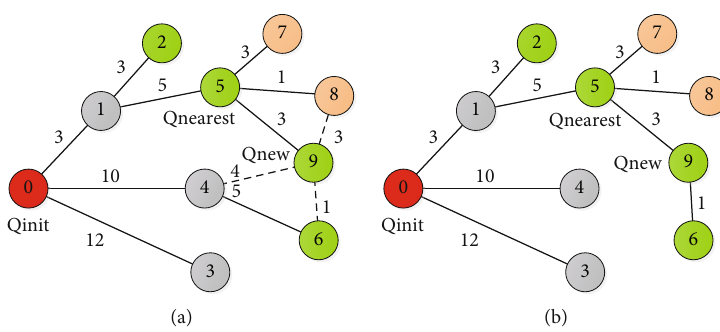
Figure 6: Process of rewiring a random tree.